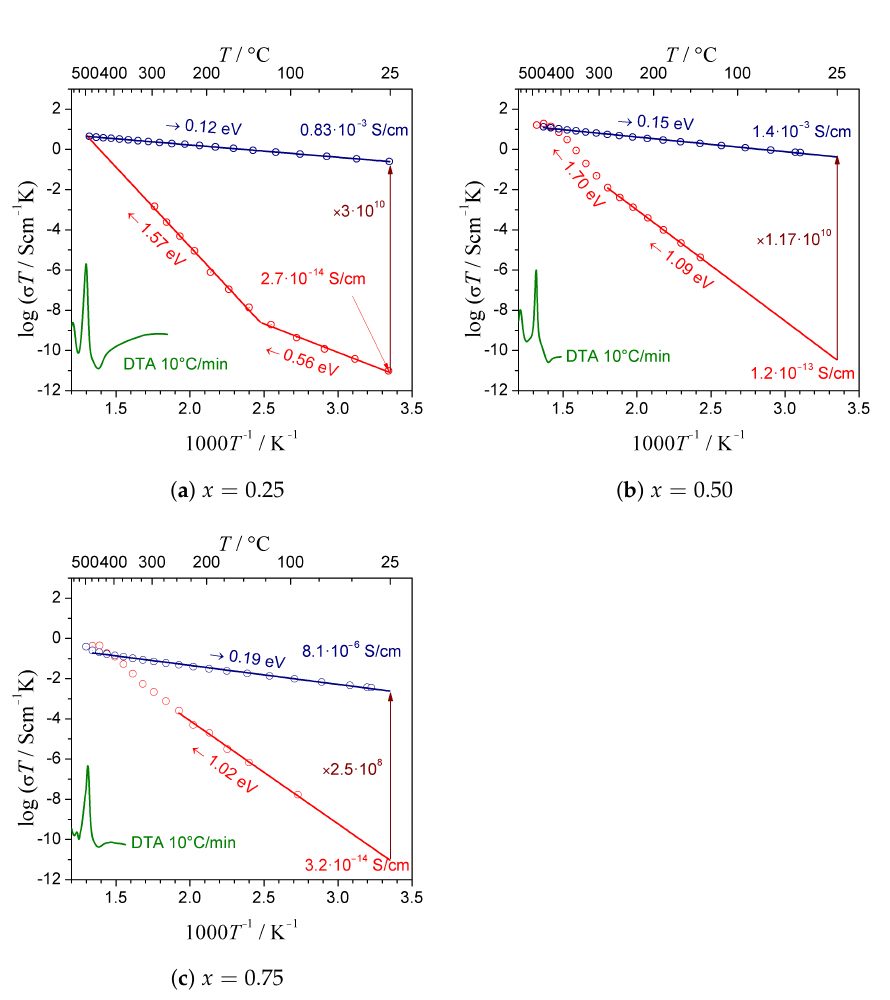
Figure 5. Dependence of electrical conductivity of samples with x = 0.25, 0.5, and 0.75 upon heating to 480 °C (red ramps) and subsequent cooling down to room temperature (blue ramps). The red and blue values of the conductivity were measured at 25 °C and are given for the starting materials and the samples after nanocrystallization, respectively. Corresponding DTA curves (green lines, shown in arbitrary units) measured with heating rate 10 °C/min are given for